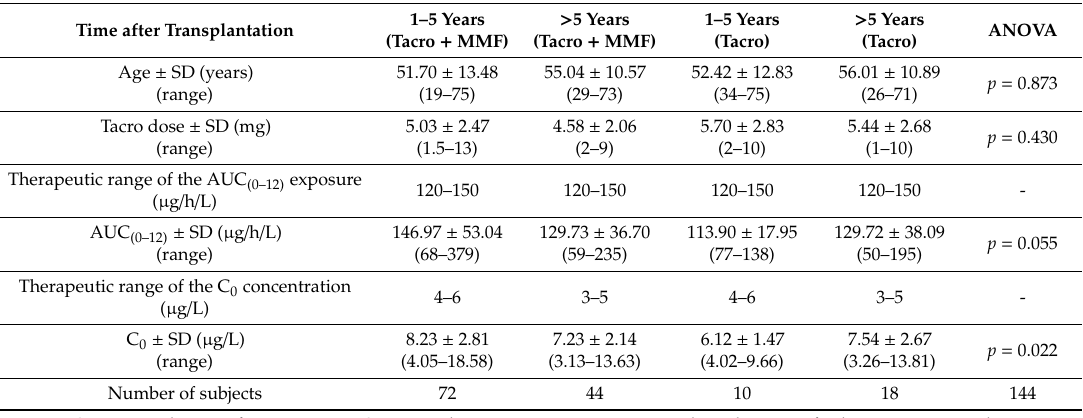
Table 2. Baseline data of tacrolimus-receiving patients.